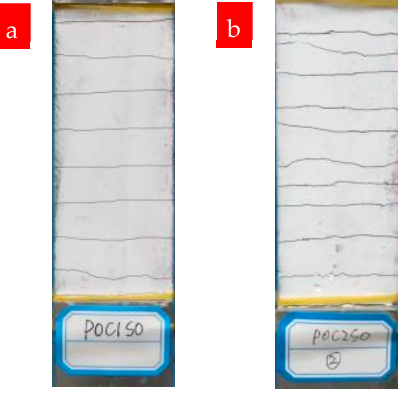
Figure 9. Cracking in TRM specimens: ( a ) P0C1S0 and ( b ) P0C2S0.